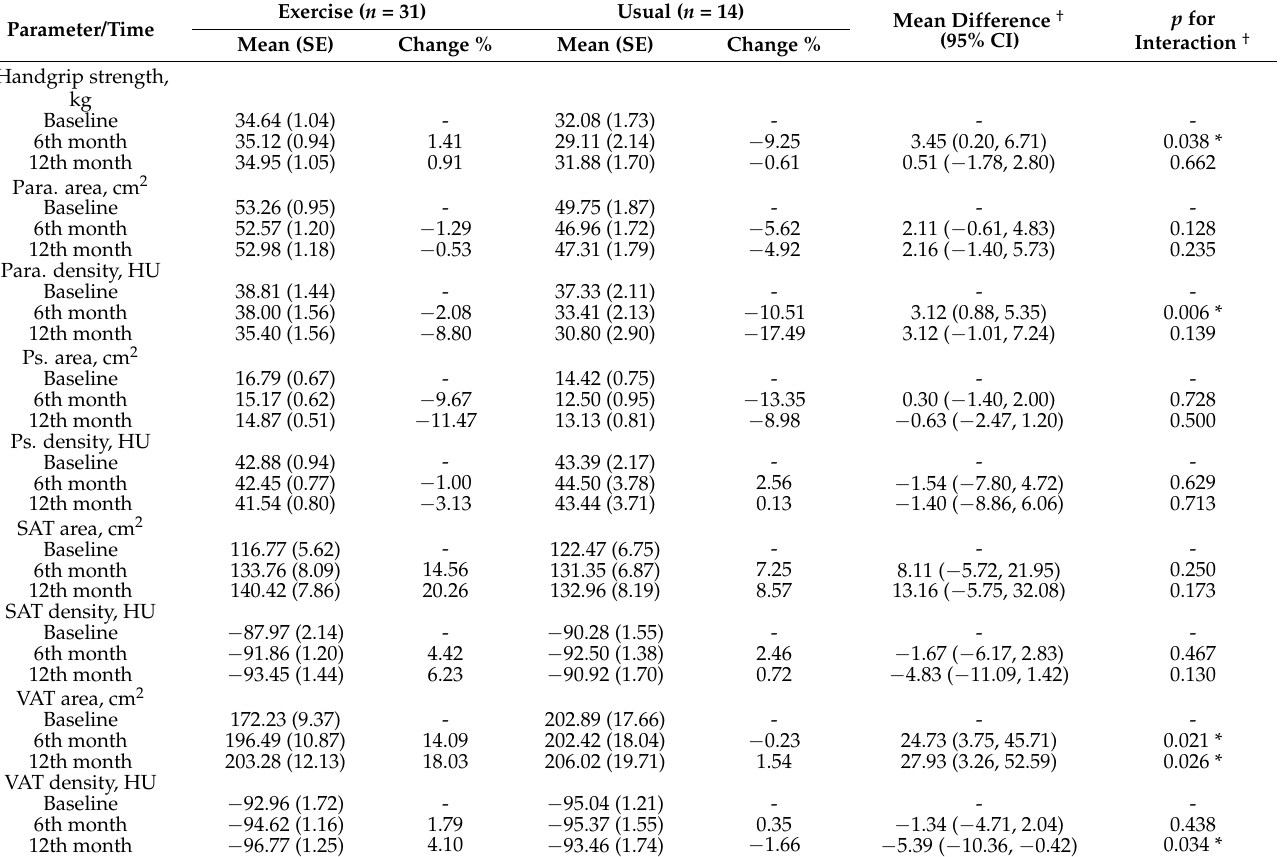
Table 3. The comparison of Handgrip and CT parameters between the exercise and usual